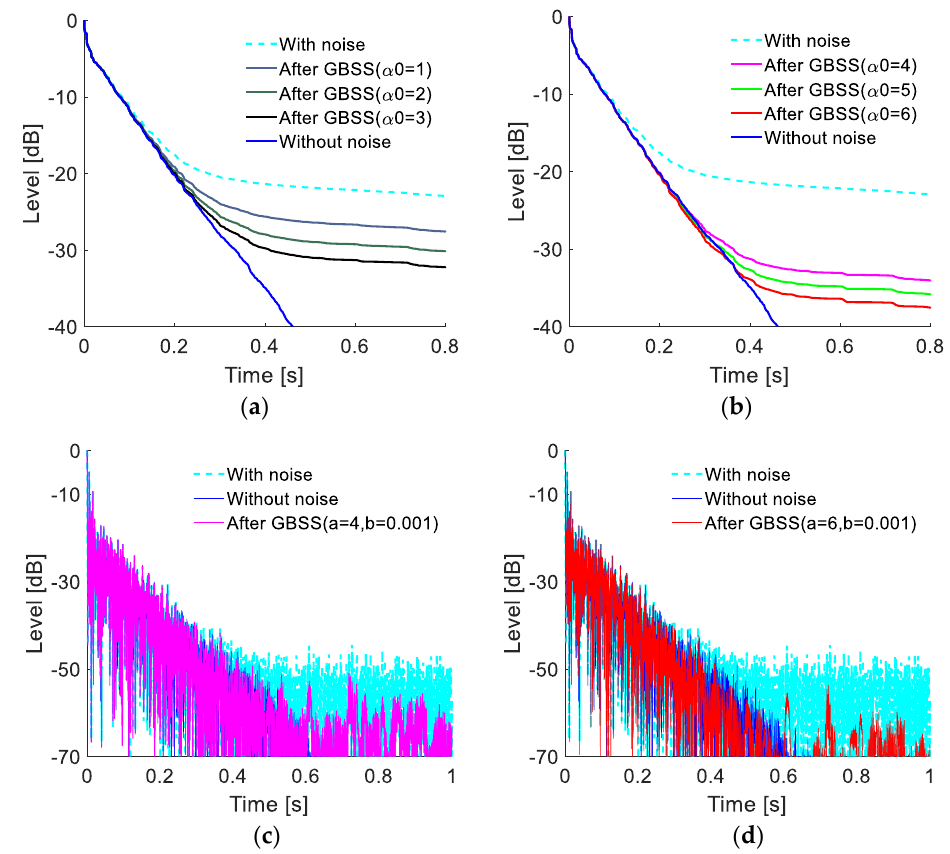
Figure 3. Comparison of the noisy RIRs and de-noised RIR at 1 kHz by varying the noise over- subtraction 𝛼 0 for a fixed value of 𝛽 . ( a , b ) Generated EDCs of the RIRs. ( c , d ) De-noised RIRs with subtraction α 0 for a fixed value of β . ( a , b ) Generated EDCs of the RIRs. ( c , d ) De-noised RIRs with α 0 𝛼 0 4 and 6 in the time domain. 4 and 6 in the time